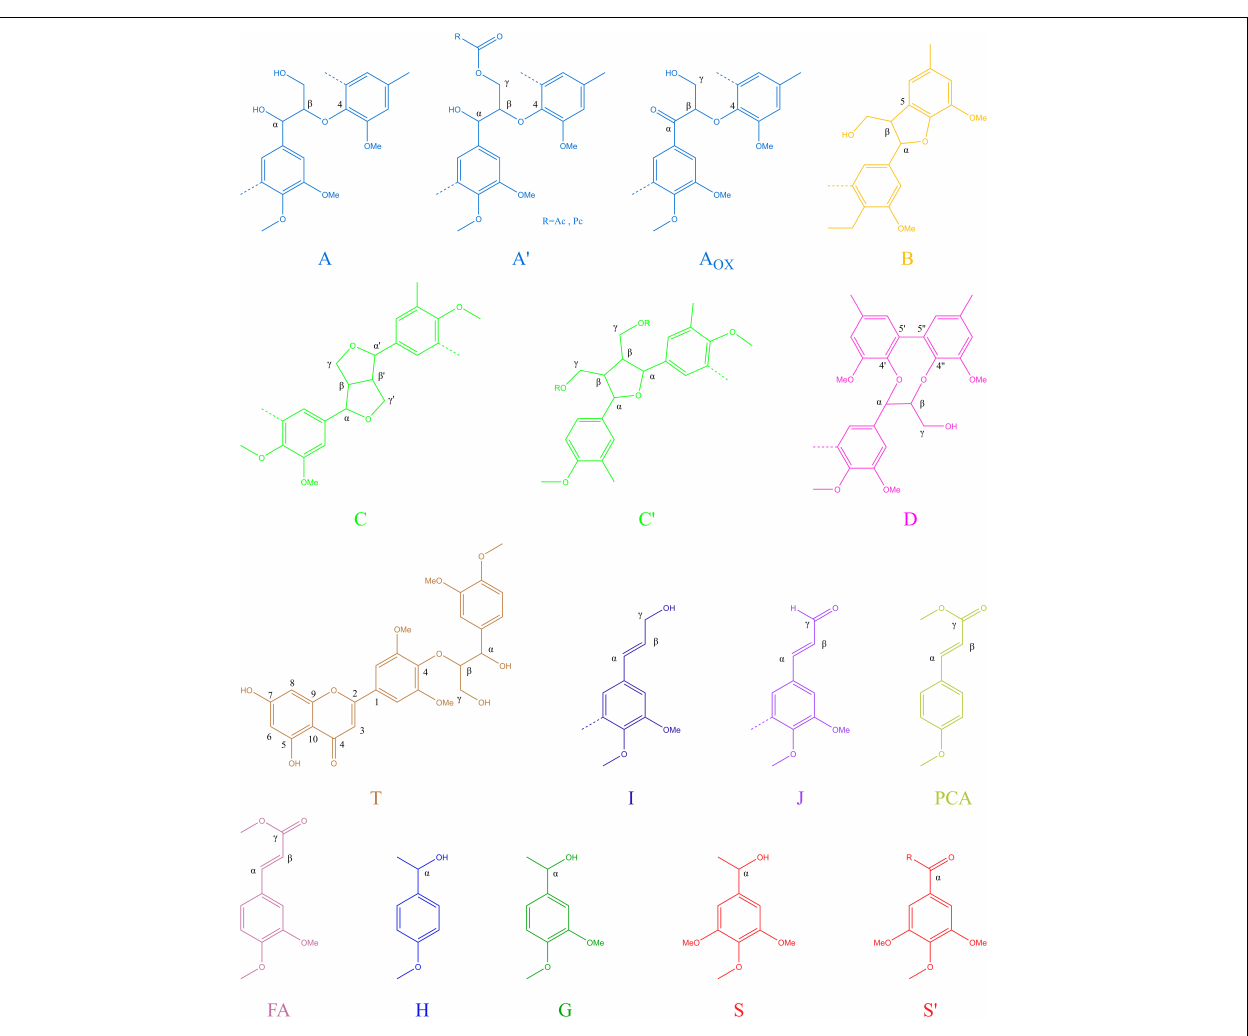
FIGURE 5 | Main structures present in the lignins of corn stalk: (A) β -O-4 (cid:48) alkyl-aryl ethers; (A (cid:48) ) β -O-4 (cid:48) alkyl-aryl ethers with acylated γ -OH; (A ox ) C α - oxidized β -O-4 (cid:48) structures; (B) phenylcoumaran;(C) resinol; (C (cid:48) ) tetrahydrofuran; (D) dibenzodioxocins; (I) cinnamyl alcohol end groups; (J) cinnamyl aldehyde end groups; (PCA) p-coumarates; (FA) ferulates; (H) p-hydroxyphenyl units; (G) guaiacyl units; (S) syringyl units; (S (cid:48) ) oxidized syringyl units bearing a carbonyl at C α